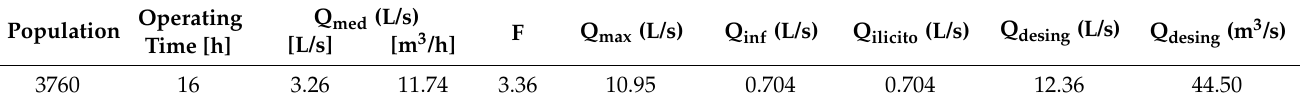
Table 16. Contribution flows from the EA1 area.